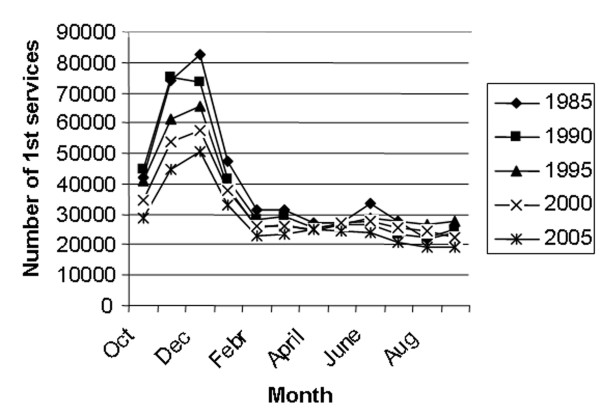
Seasonal distribution of first inseminations every 5th year from 1985 to 2005.